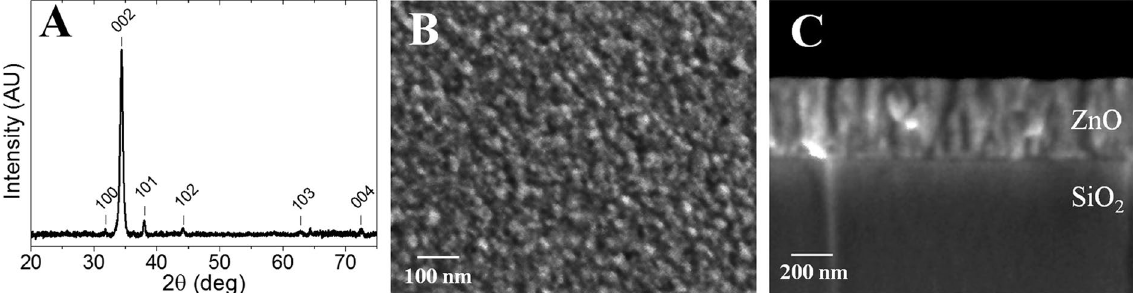
Figure 2. X-ray diffraction spectra showing the c-axis oriented hexagonal structure of the ZnO film on a polyimide substrate ( A ). Surface ( B ) and cross-section ( C ) SEM images indicated a film of 85 nm ZnO film deposited by PLD on a SiO 2 /Si substrate at 250 °C.